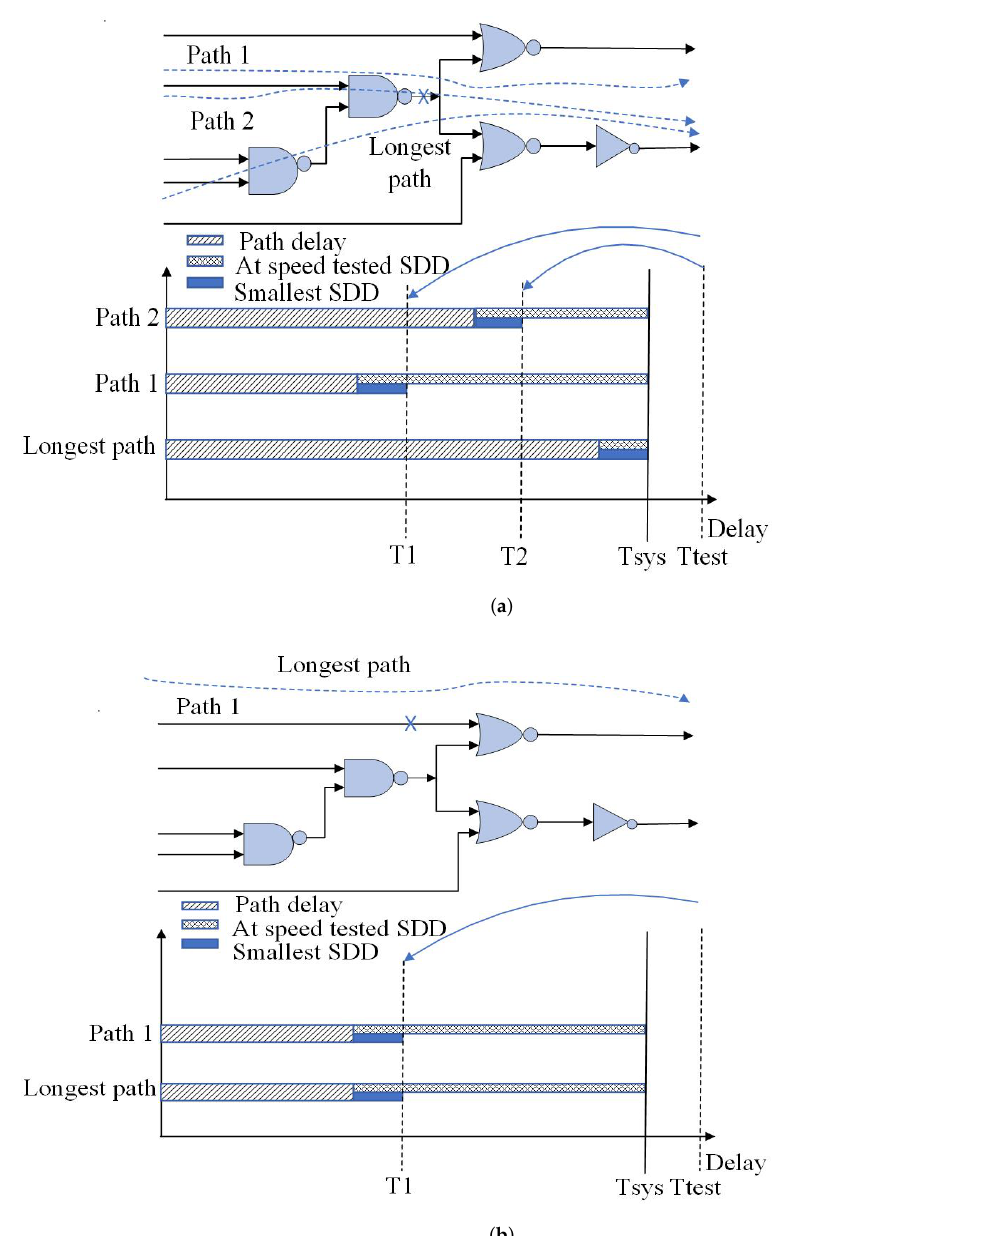
Figure 5. ( a ) Delay of each path of the circuit through fault site X and the observation time T1 and T2 for detecting the small delay; ( b ) Delay of the path through the fault site X and the observation time T1 to detect the hidden